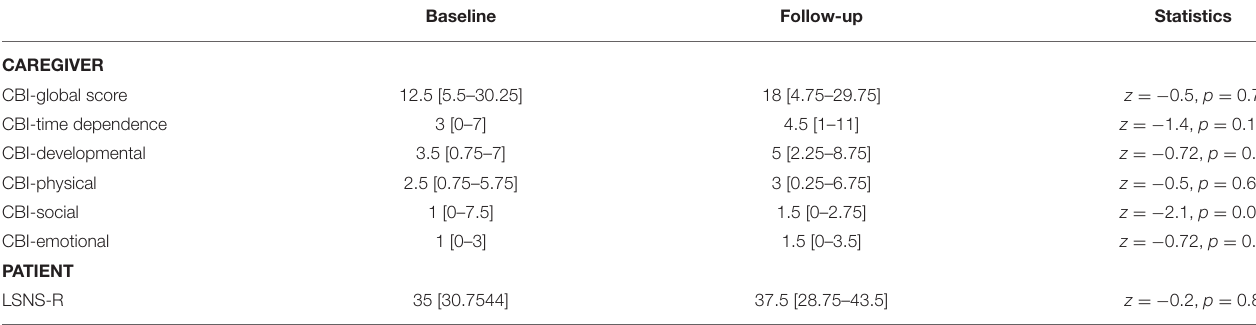
TABLE 2 | Pre-post comparison of Caregiver Burden Inventory (CBI) and Lubben Social Network Scale-Revised (LSNS-R).